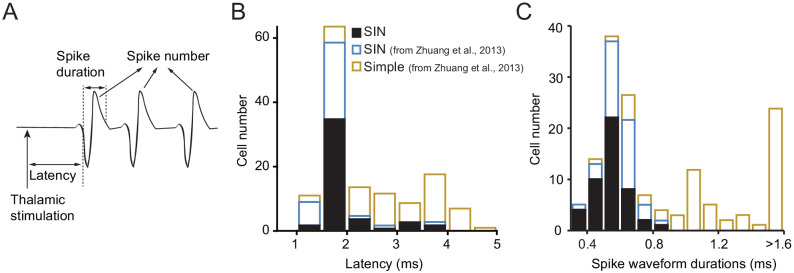
Some characteristics of L4 SINs.(A) Schematic illustration of how we measured spike duration and latency to thalamic stimulation. (B) Distributions of latencies to LGN electrical stimulation for the L4 SINs studied here, compared to L4 SINs and simple cells studied by Zhuang et al., 2013. (C) Distribution of spike waveform duration measures for the L4 SINs studied here, compared to L4 SINs and simple cells studied by Zhuang et al., 2013.